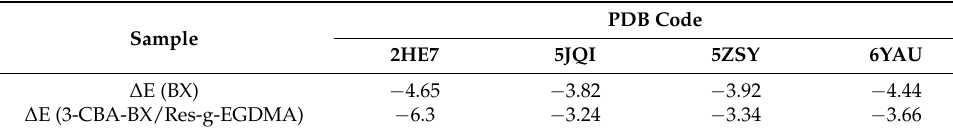
Table 1. Binding free energy of BX and 3-CBA-BX/Res-g-EGDMA. Sample